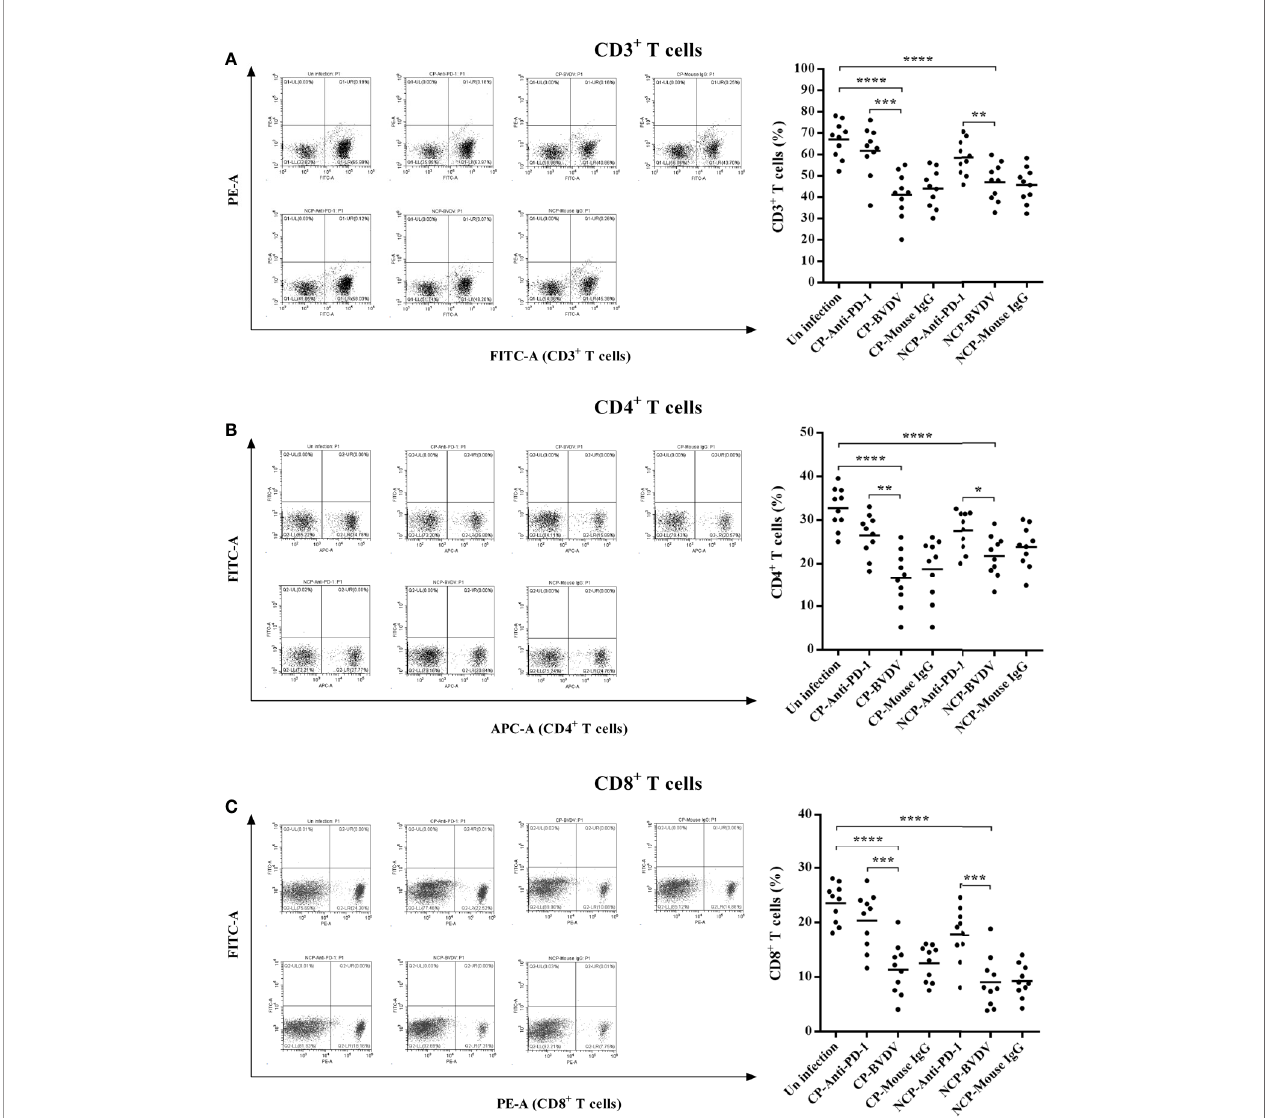
FIGURE 8 | Effect of PD-1 blockade on the proportions of CD3 + , CD4 + , and CD8 + T cell subsets at day 7 of post-infection. (A) CD3 + T cells, (B) CD4 + T cells, (C) CD8 + T cells. **** p < 0.0001, *** p < 0.001, ** p < 0.01, * p < 0.05. The animals were assigned into 7 experimental groups, including the mock-infected group, CP BVDV-infected group, CP BVDV+anti-PD-1 group, CP BVDV+mouse IgG group, NCP BVDV-infected group, NCP BVDV+anti-PD-1 group, and NCP BVDV+mouse IgG group. CP and NCP BVDV-infected mice were used as the controls. Data are presented as mean ± SD (n = 10 per group) and analyzed using one-way